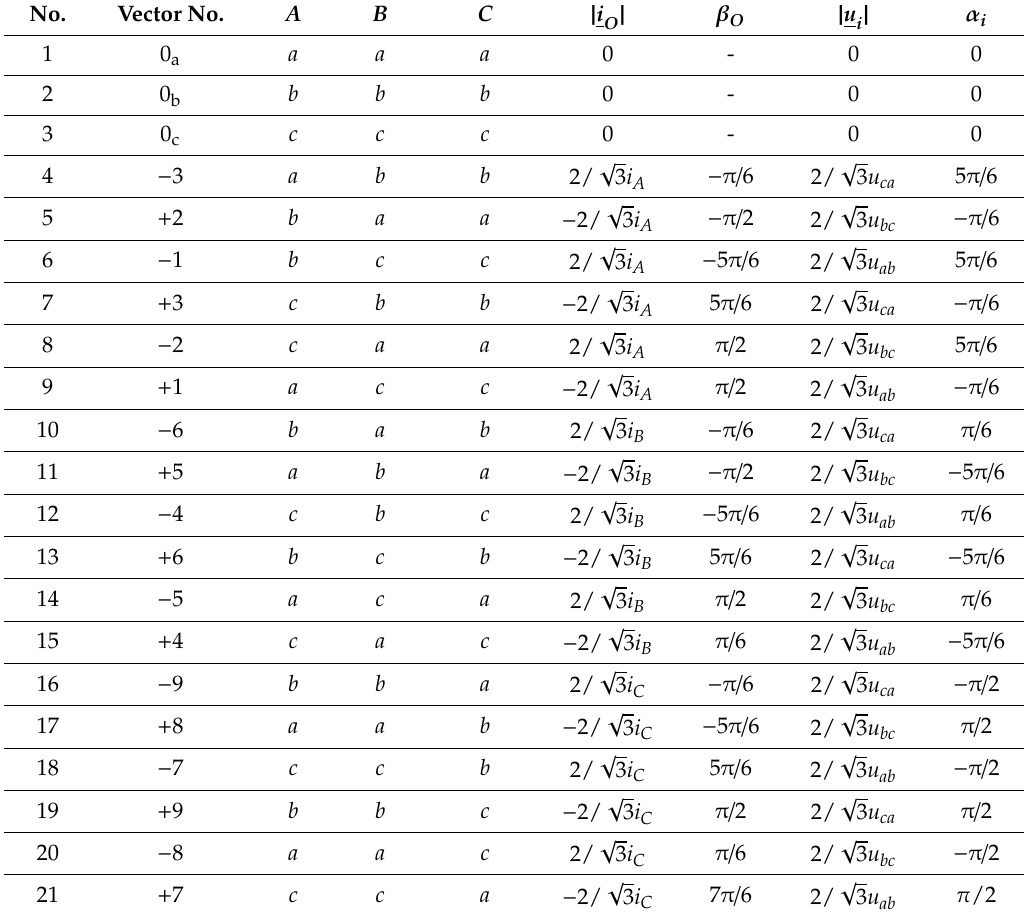
Table 2. Acceptable switch configurations in Space Vector Modulation (SVM) for CSMC.